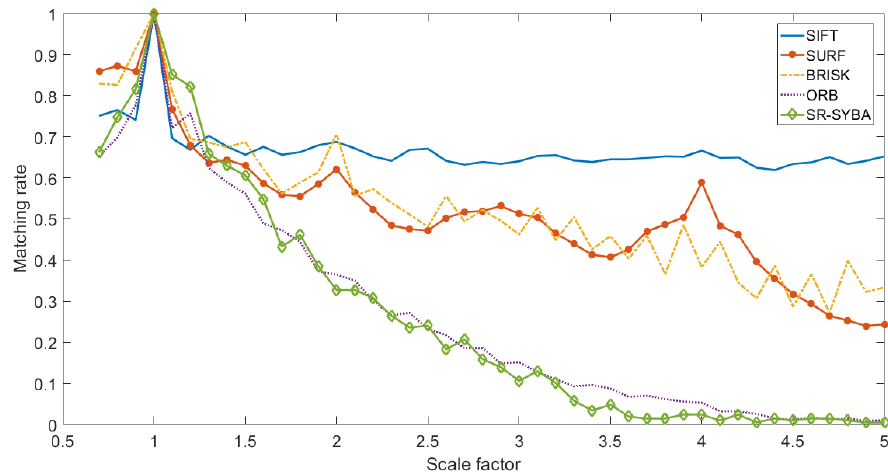
Figure 13. Comparison with scaling variations.